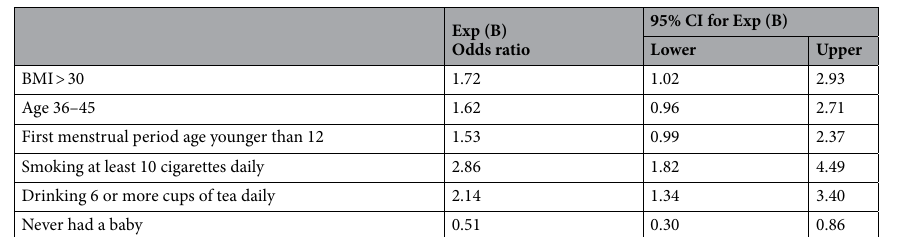
Table 5. Logistic regression model of risk factors (periodic mastalgia)—backward method results. Pseudo (Nagelkerke) R 2 = 0.164, Hosmer–Lemeshow χ 2 = 40.723, p < 0.001 (Step 7). Dependent variable: 1: mastalgia absent; 0: mastalgia present. CI confidence interval, OR odds ratio, BMI body mass index.